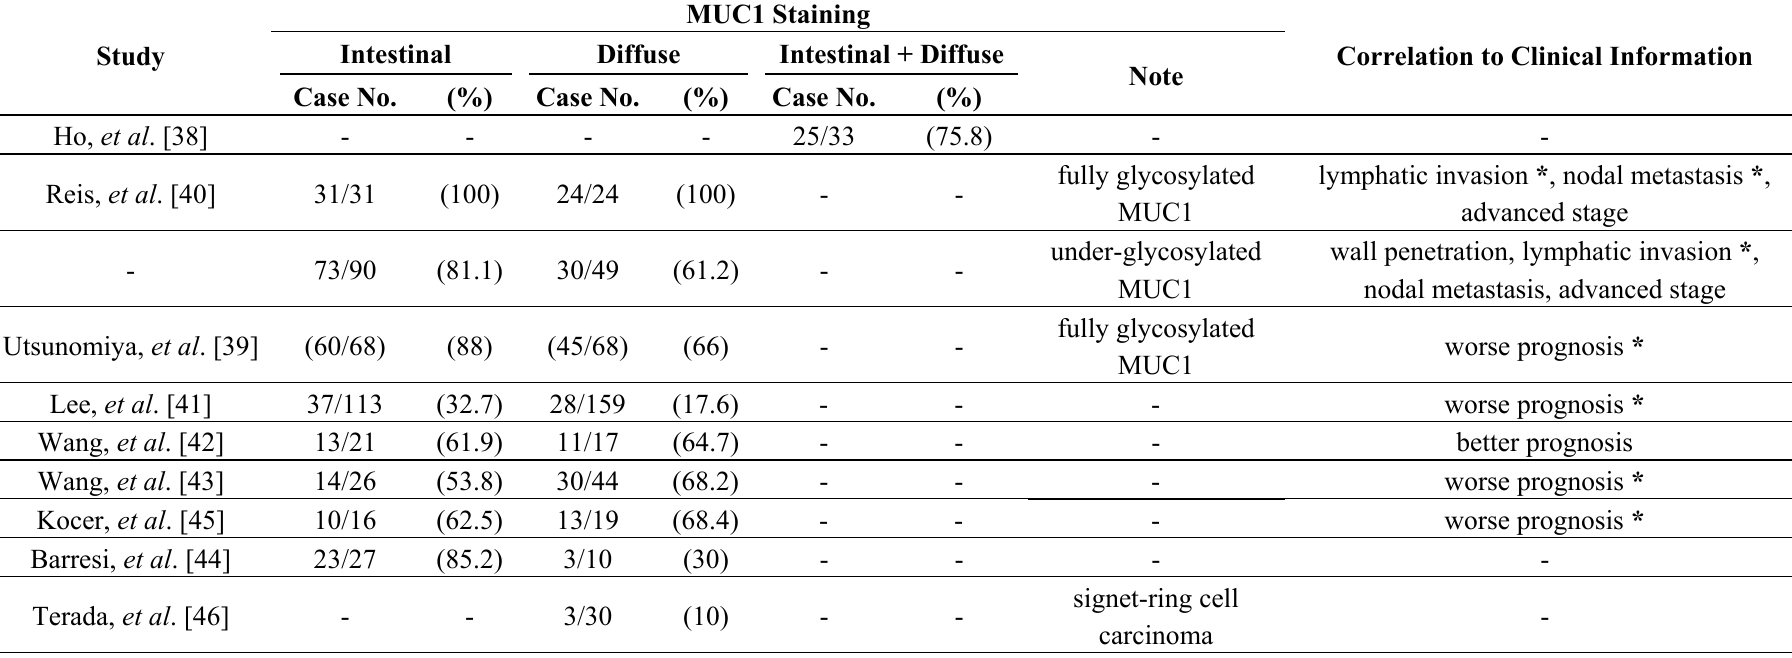
Table 2. MUC1 expression in gastric cancer observed by